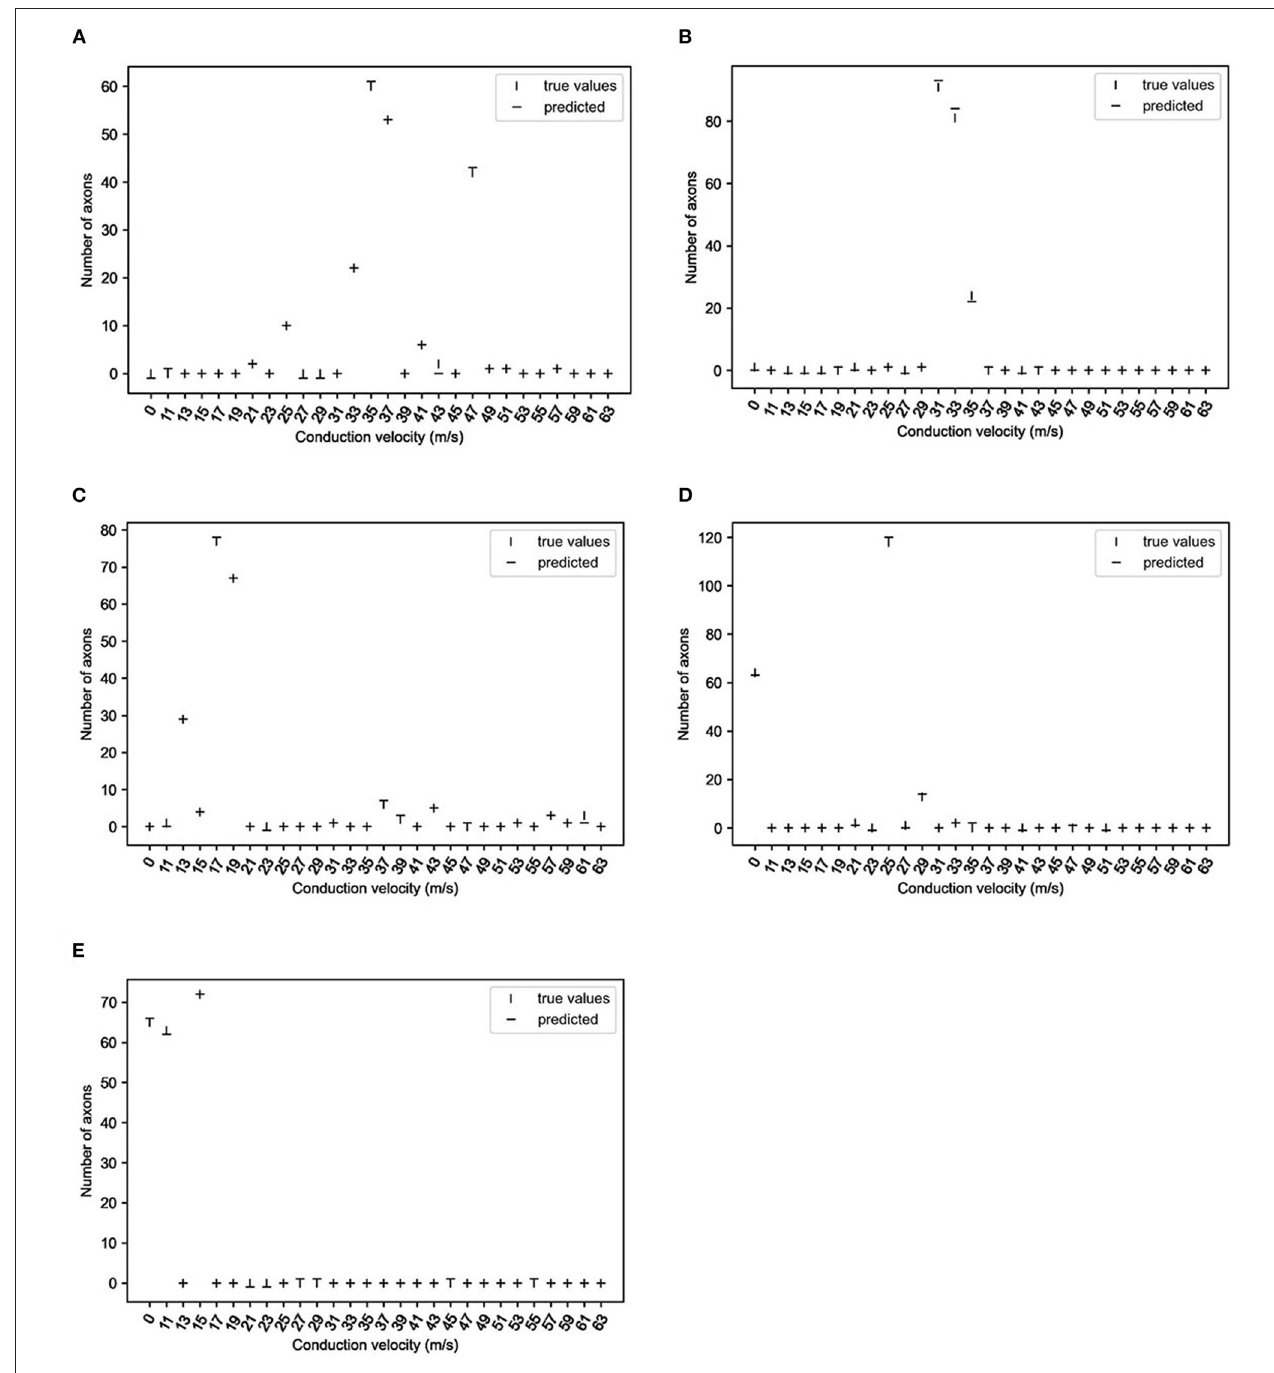
FIGURE 4 | True and predicted values of representative data (two-layer bidirectional long short-term memory; 10,000 epochs). The vertical lines show the number of axons at the respective conduction velocities, and horizontal lines predicted the numbers of axons. (A) : without CB1; (B) : without CB3; (C) : without CB6; (D) : with CB3; (E) : with CB6 (see Table 2 for group